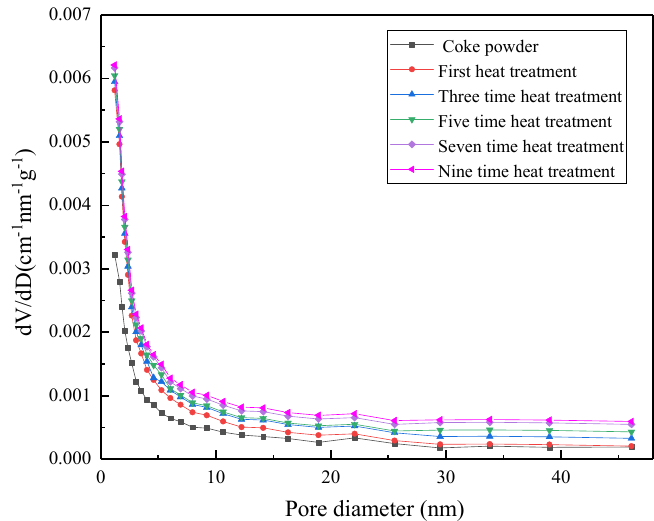
Figure 11. The change in the pore size distribution of coke powder before and after heat treatment.